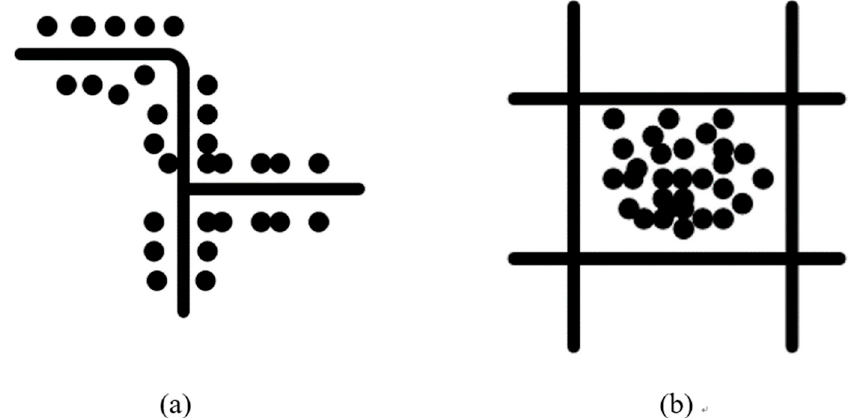
Figure 2. The spatial distribution of POIs. (a) Along the street; (b) concentrated around a